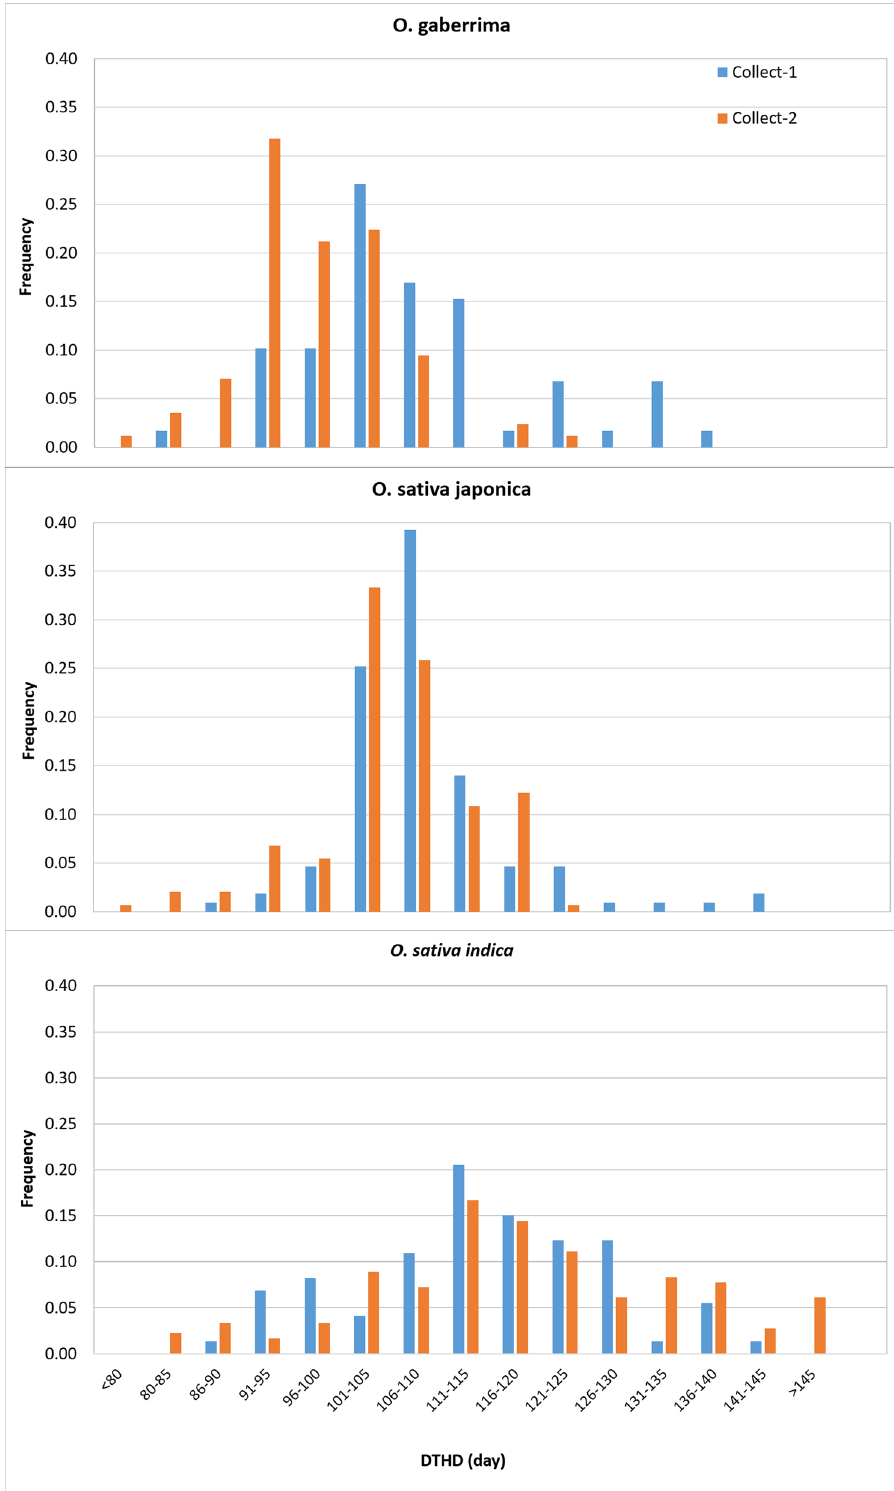
Fig. 3 Distribution of frequency of accessions of the two collect times (Collect-1 and Collect-2) in different classes of duration of the vegetative phase expressed in number of days between the sowing date and the heading date